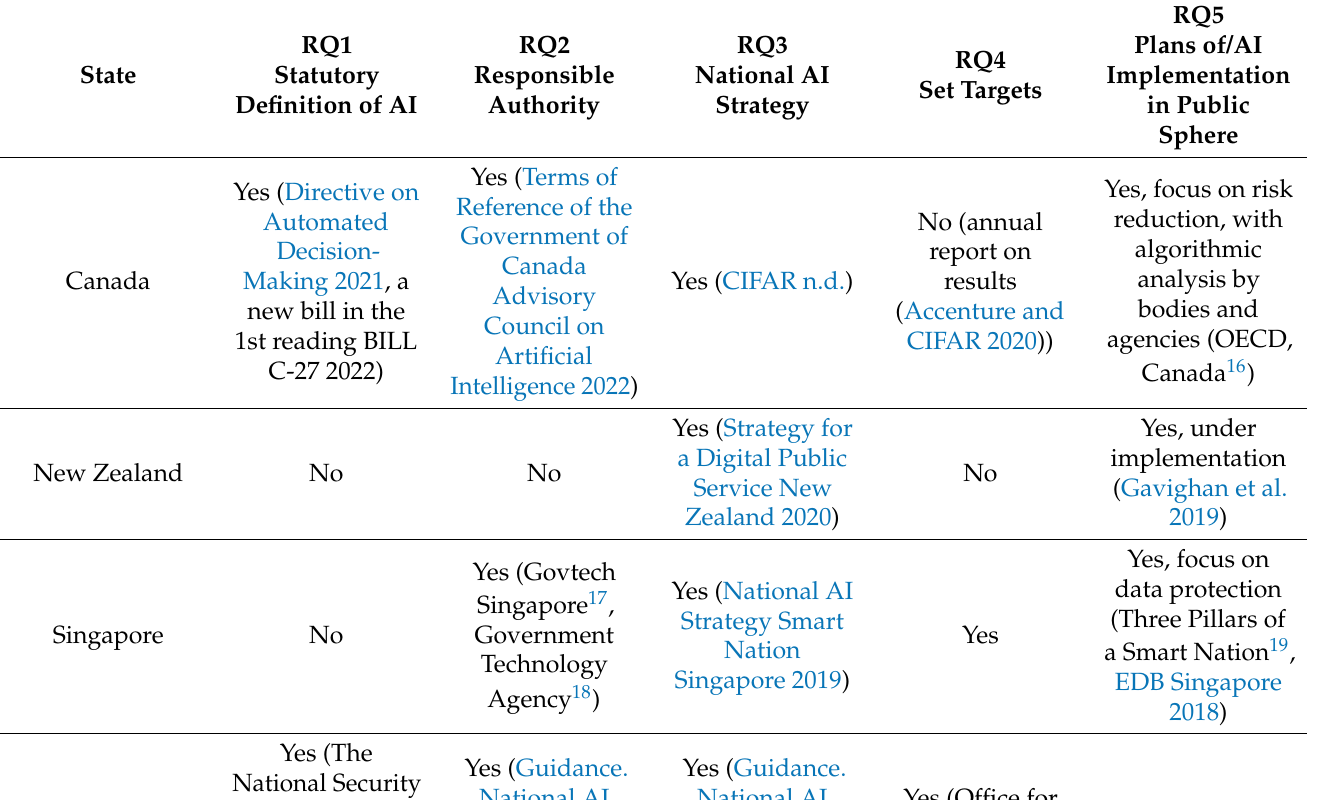
Table 3. Comparative analysis of national strategies in the field of AI of the leading countries of the Anglo-Saxon legal system (compiled by the